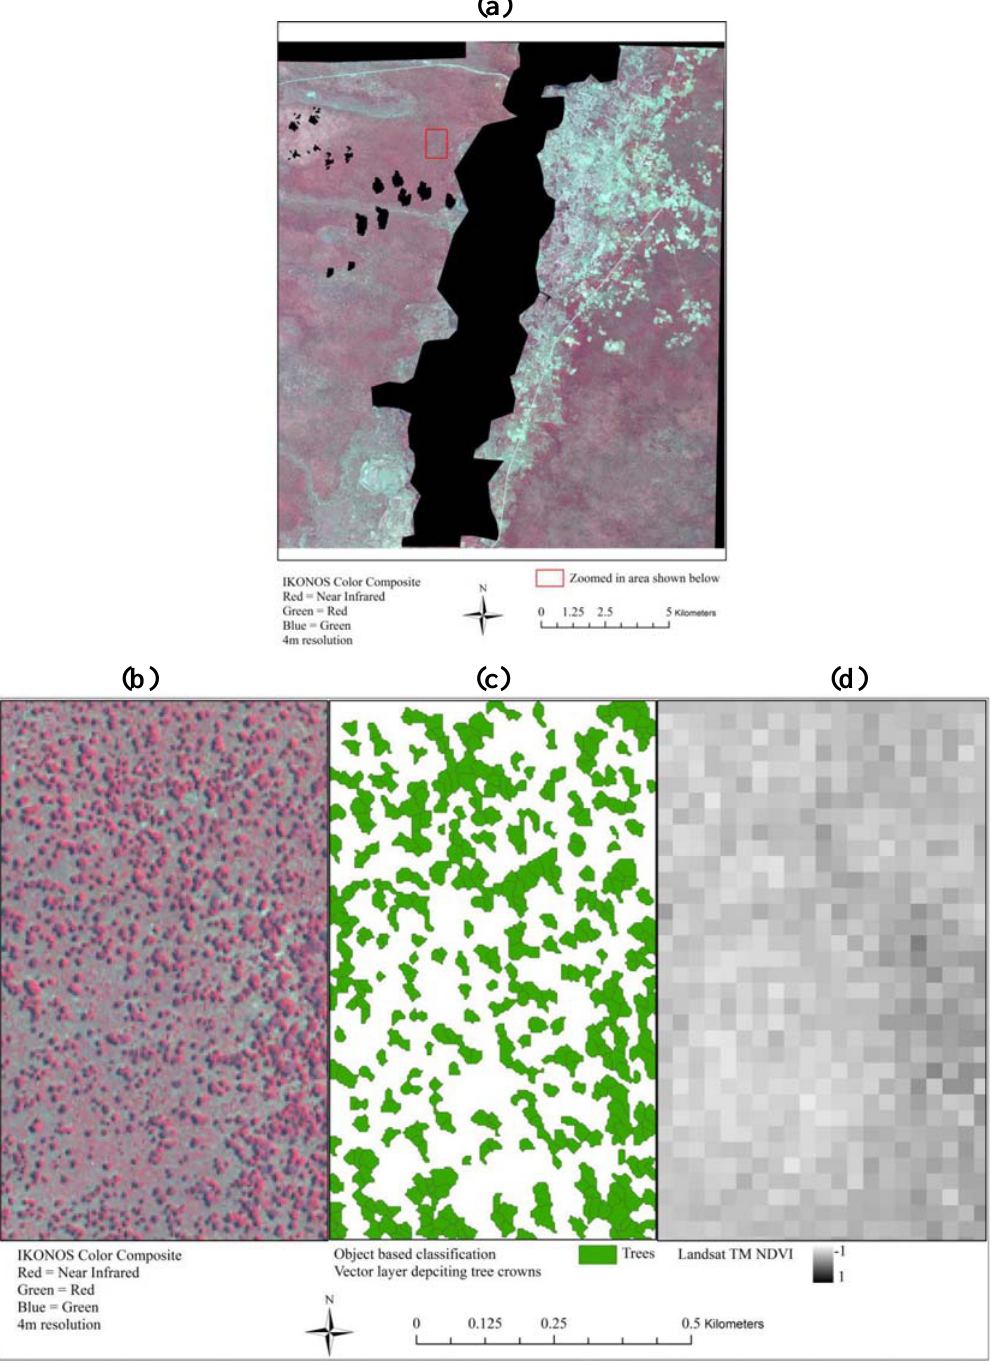
Figure 5. Results of the object based classification for the region, illustrated with the larger study are and then a blow up of the focus region to enable the reader to “see” actual polygon results from the landscape. Figures shown are for (a) the IKONOS imagery for the entire study region, (b) the focus region in the IKONOS imagery (color composite RGB = near infrared, red, green where red represents vegetation and cyan represents bare earth), (c) the resultant OBC of individual tree polygons calculated from the IKONOS data which though not perfect offers an alternative to pixel based approaches, and (d) the Landsat NDVI image of the focus region, clearly illustrating the differences in